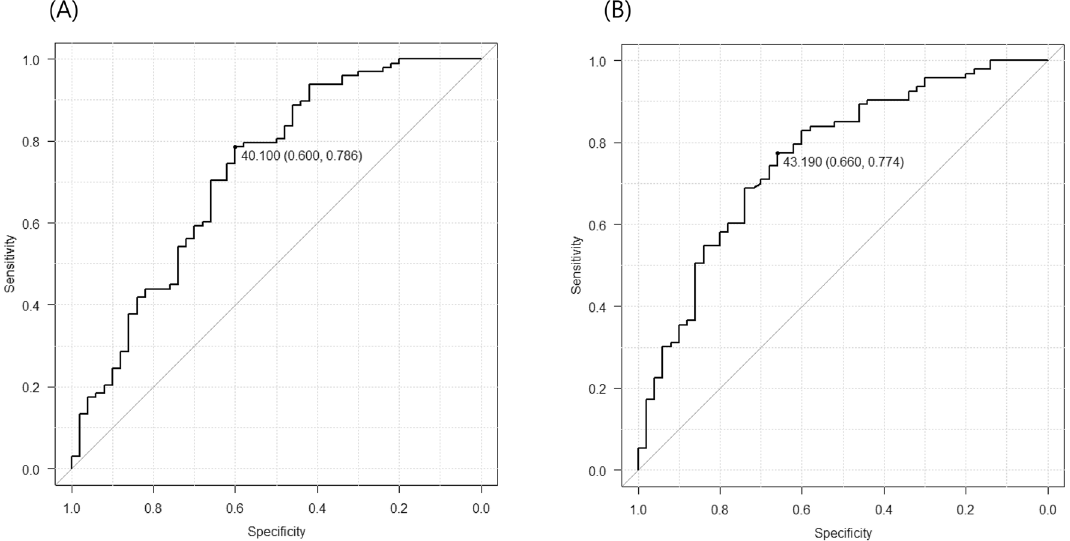
Figure 2. Receiver operating characteristic curves between patients with episodic migraine and healthy controls ( A ) as well as between patients with chronic migraine and healthy controls ( B ). The points for maximal area under the curve are highlighted with the sensitivity and specificity values.